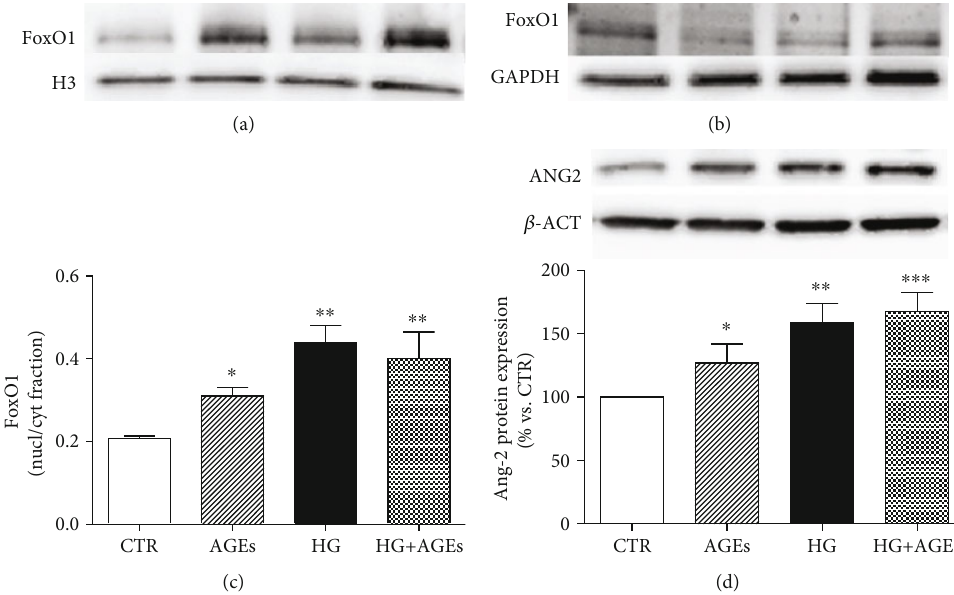
Figure 4: AGEs and HG increased expression of Ang-2. HMEC-1 cells were cultured for 5 days in standard medium (CTR), in the presence of glycated serum (AGEs), 25mM glucose (HG), and with their combination (AGEs+HG). Western blot analysis of nuclear (a) and cytosolic (b) localization of FoxO1. Histone H3 and GAPDH amounts were analyzed as loading controls. (c) Graph represents relative ratio between nuclear and cytosolic fractions ( n = 3 , ∗ p < 0 : 05 and ∗∗ p < 0 : 01 vs. CTR). (d) Western immunoblotting of Ang-2. Representative western blot analysis and quanti fi cation of densitometries of western blot band. Data were expressed as mean ± SEM of fold induction relative to β -actin. Values shown indicate the mean SEM of at least 3 independent experiments ( n = 3 , ∗ p < 0 : 5 , ∗∗ p < 0 : 01 and ∗∗∗ p < 0 : 001 vs.